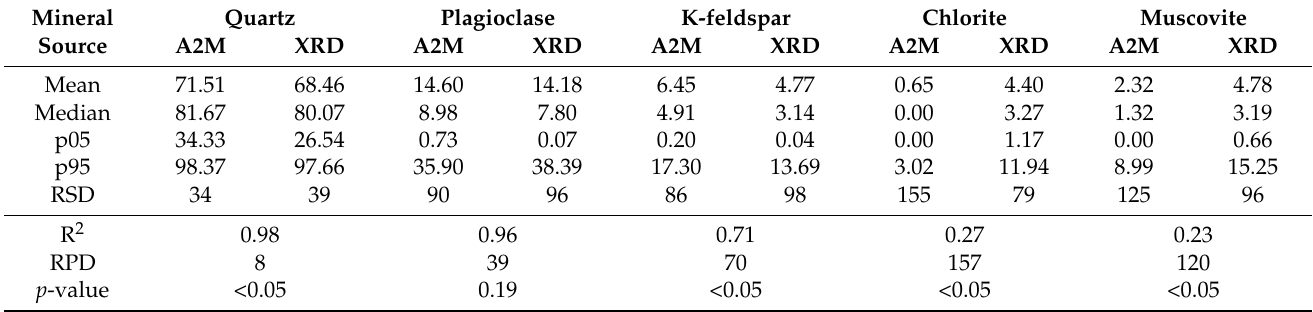
Table 5. Statistical summary (p05 is the 5th percentile, p95 the 95th percentile, and RSD is Rela- tive Standard Deviation) for predicted A2M (Analysis to Mineralogy) and estimated XRD (X-ray Diffraction) mineralogy (wt%) at 66 study sites in Alberta, Saskatchewan, and Ontario (secondary evaluation). Statistical comparison of the two data sets using coefficient of determination (R 2 ), Relative Percent Difference (RPD), and paired t -test ( p -value) is also shown for each